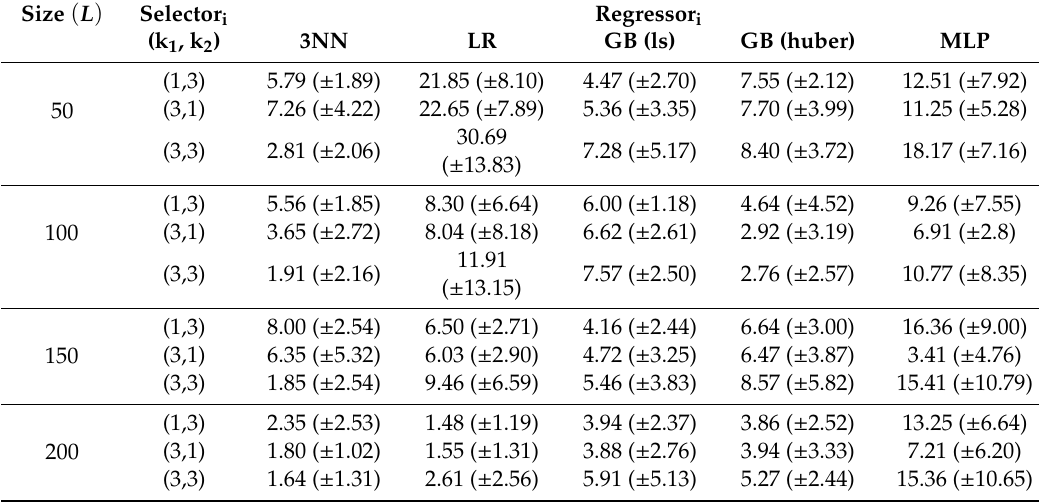
Table 5. Relative improvement of MAE metric ( ± std) of the dataset based only on the first and second semester during the best iteration per di ff erent combination of selector and